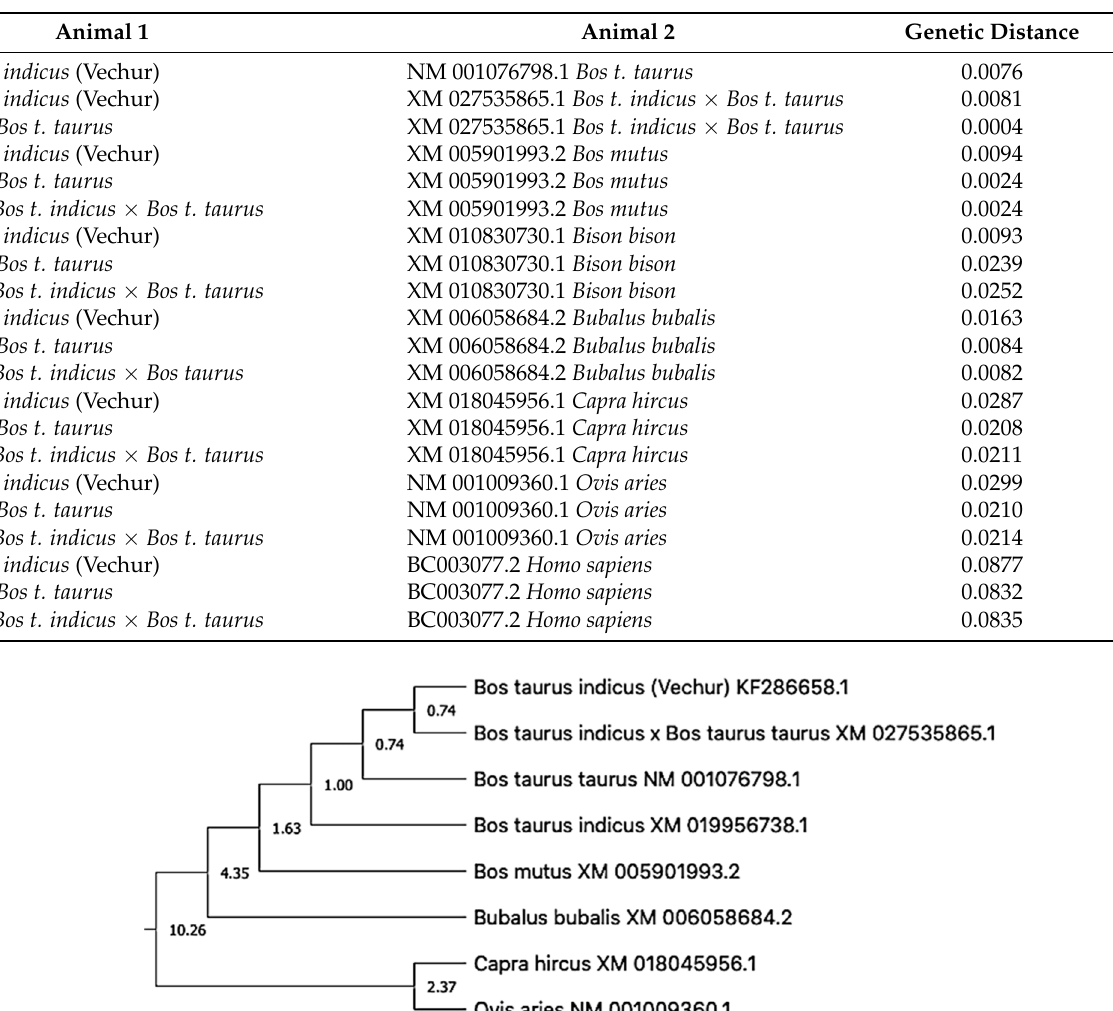
Figure 6. Timetree depicting the evolutionary molecular clock of the ATP1A1 gene in dwarf Vechur ( Bos taurus indicus ) cattle. The branch lengths were calculated using the maximum likelihood (ML) method and the Tamura-Nei substitution model inferred by applying the RelTime method. Table 2. Estimated marginal means (EMM) of the relative expression of ATP1A1 gene in different breeds of cattle at different periods from 08:00 to 12:00 (standard error = 0.37; df = 18). Period 1 was between 08:00 and 10:00; period 2 was between 10:00 and 12:00; period 3 was between 08:00 and